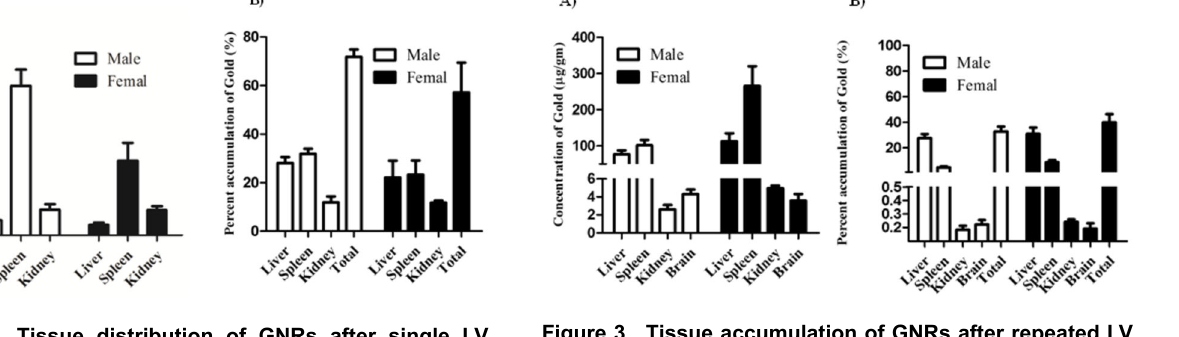
Figure 2. Tissue distribution of GNRs after single I.V. administration to male and female normal animals. GNRs were administered by I.V. injection (0.1 mg/kg) and assayed after two weeks in major excretory organs (liver, spleen and kidney). Concentration of GNRs (A) and the percent residual amount of the total administered dose (B) are presented. Data are presented as mean ± SEM (n=6).